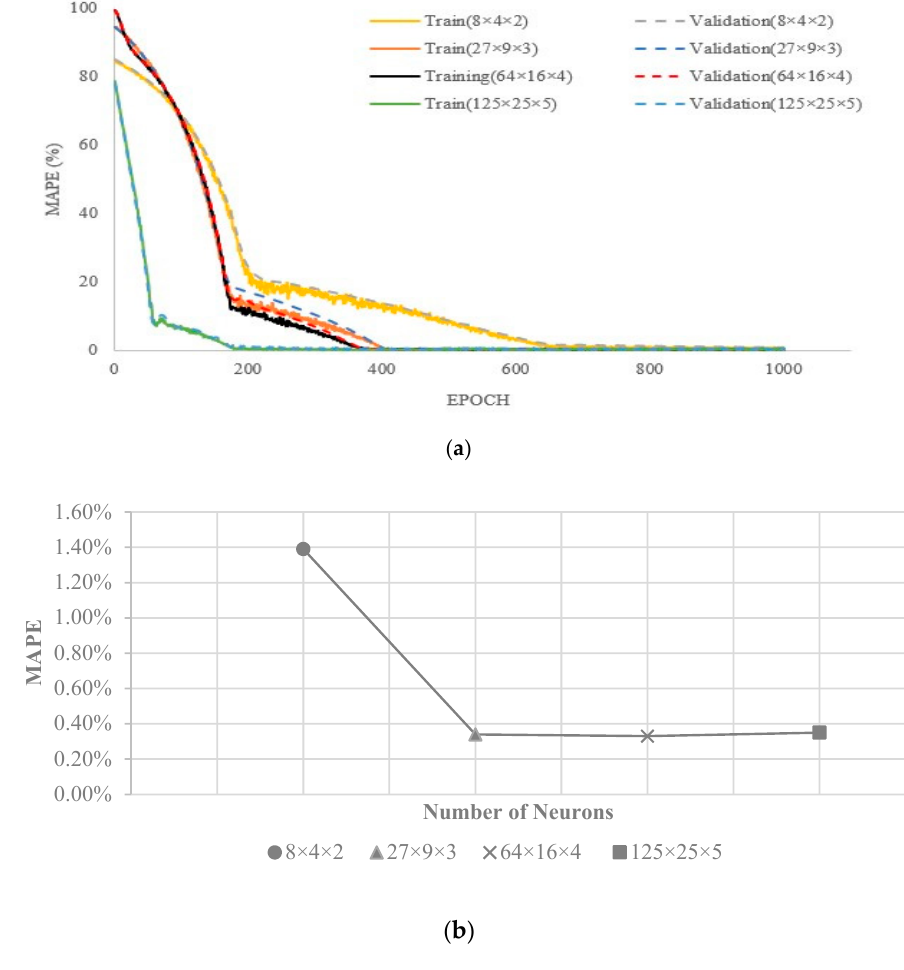
Figure 7. Selection of the number of neurons for the DNN model: ( a ) accuracy of DNN model with training and validation in terms of MAPE. ( b ) accuracy of DNN model with test in terms of MAPE. Size of Epoch